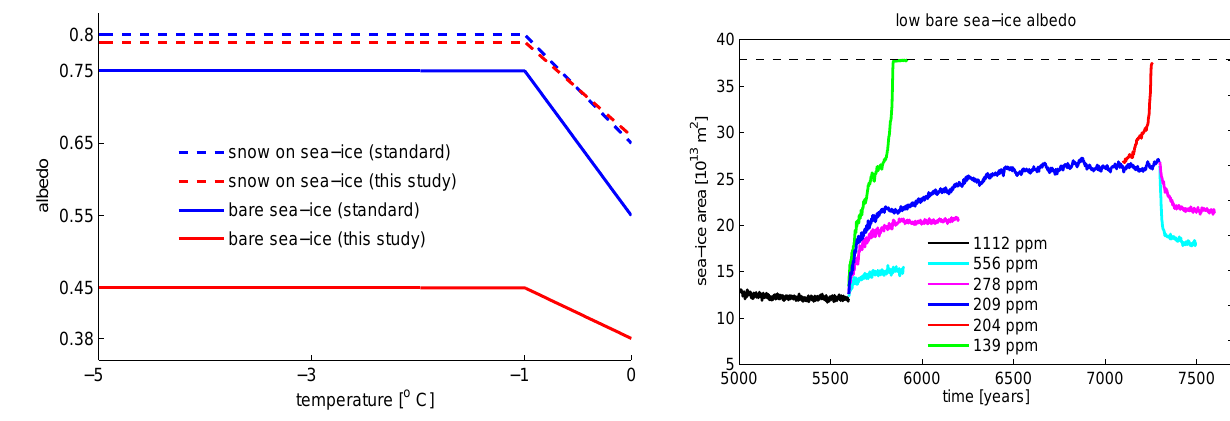
Fig. 2. Albedo of snow on sea ice (dashed) and bare sea ice (solid) of the standard setup of ECHAM5/MPI-OM used in Voigt et al. (2011) and Voigt and Marotzke (2010) (blue) and the values adopted from the Community Atmosphere Model version 3 used in this study (red).